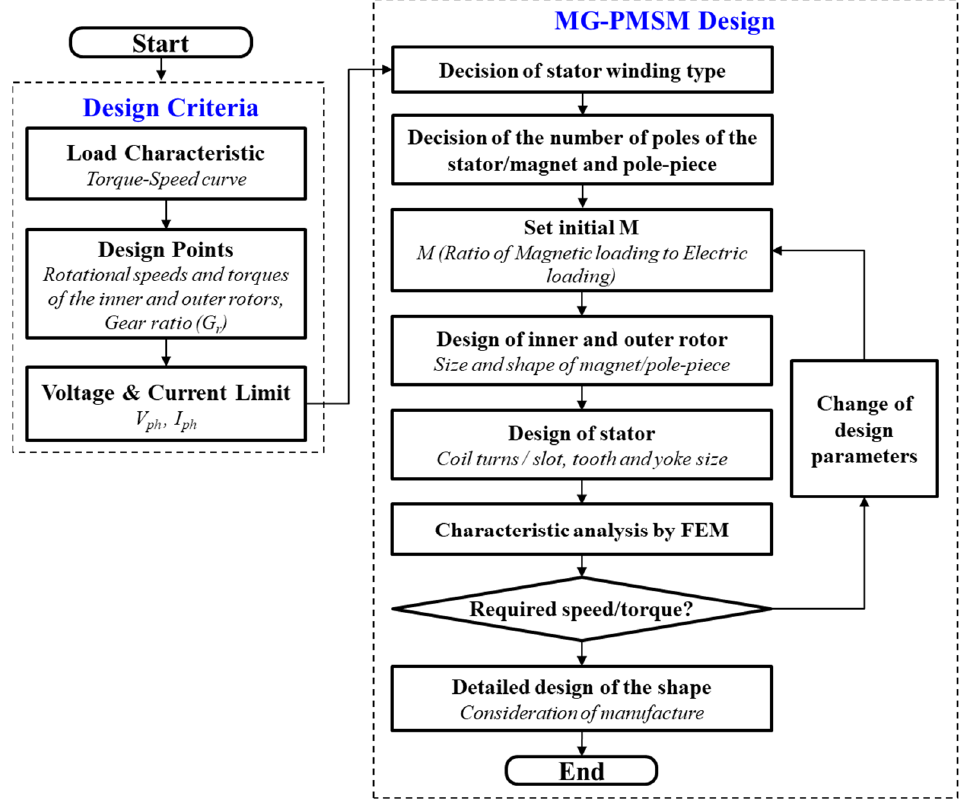
Figure 6. Design process of MG-PMSM for tram vehicle traction. Table 2. Comparison of the design results of 45kW-class MG-PMSM basic design model candidates with distributed winding.